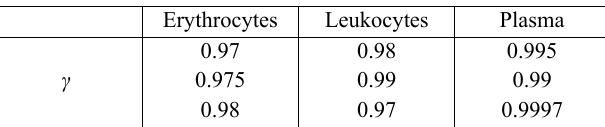
Table 2. Exponent of the fractional differential equation that best fits the